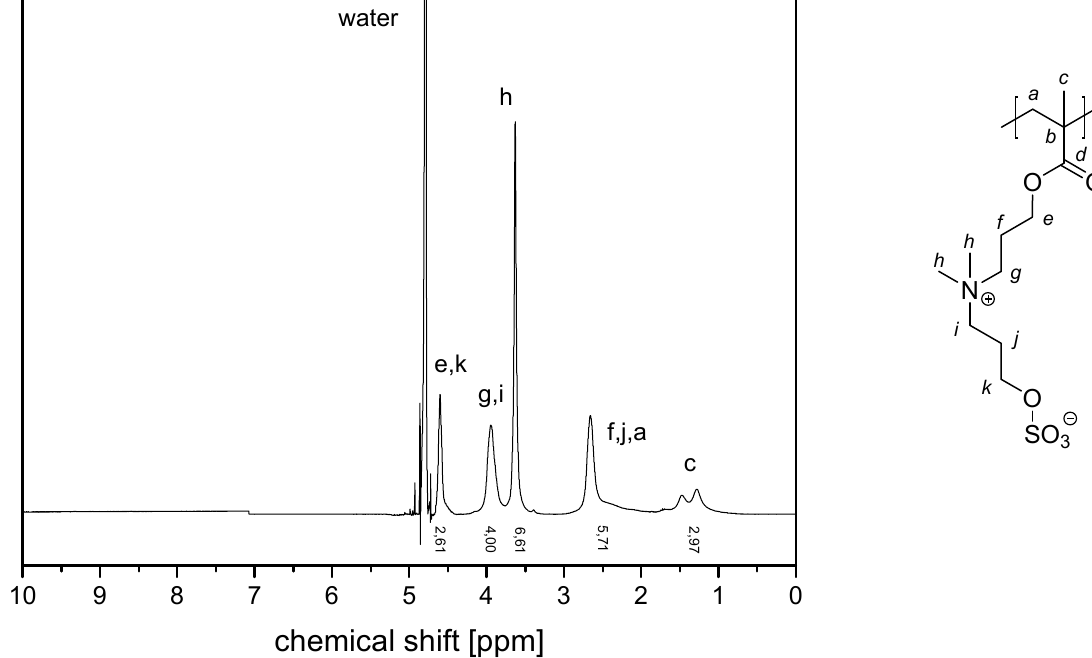
Figure A14. 1 H NMR-spectrum of polymer P − 2d in D 2 O saturated with NaCl .